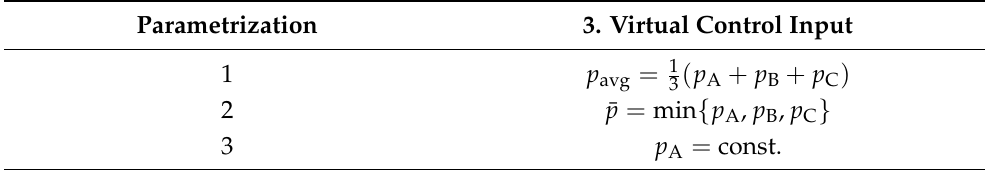
Table 1. Different virtual control input parametrizations: The virtual control inputs ∆ p α , ∆ p β are used for all three parametrizations, but the third virtual control input is different for each